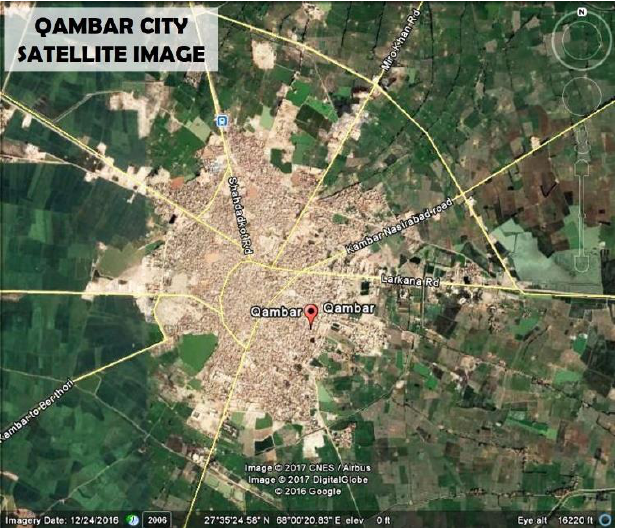
Fig. 3. Satellite image of Qambar city with built up area and